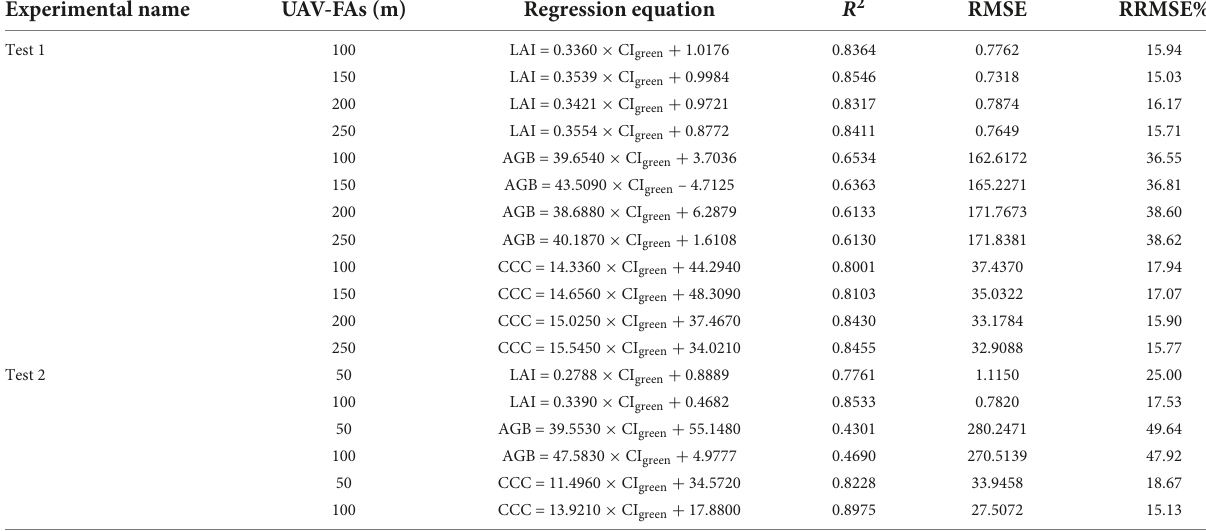
TABLE 6 The linear regression models for monitoring rice growth parameters based on different UAV-FAs in Test 1 and Test